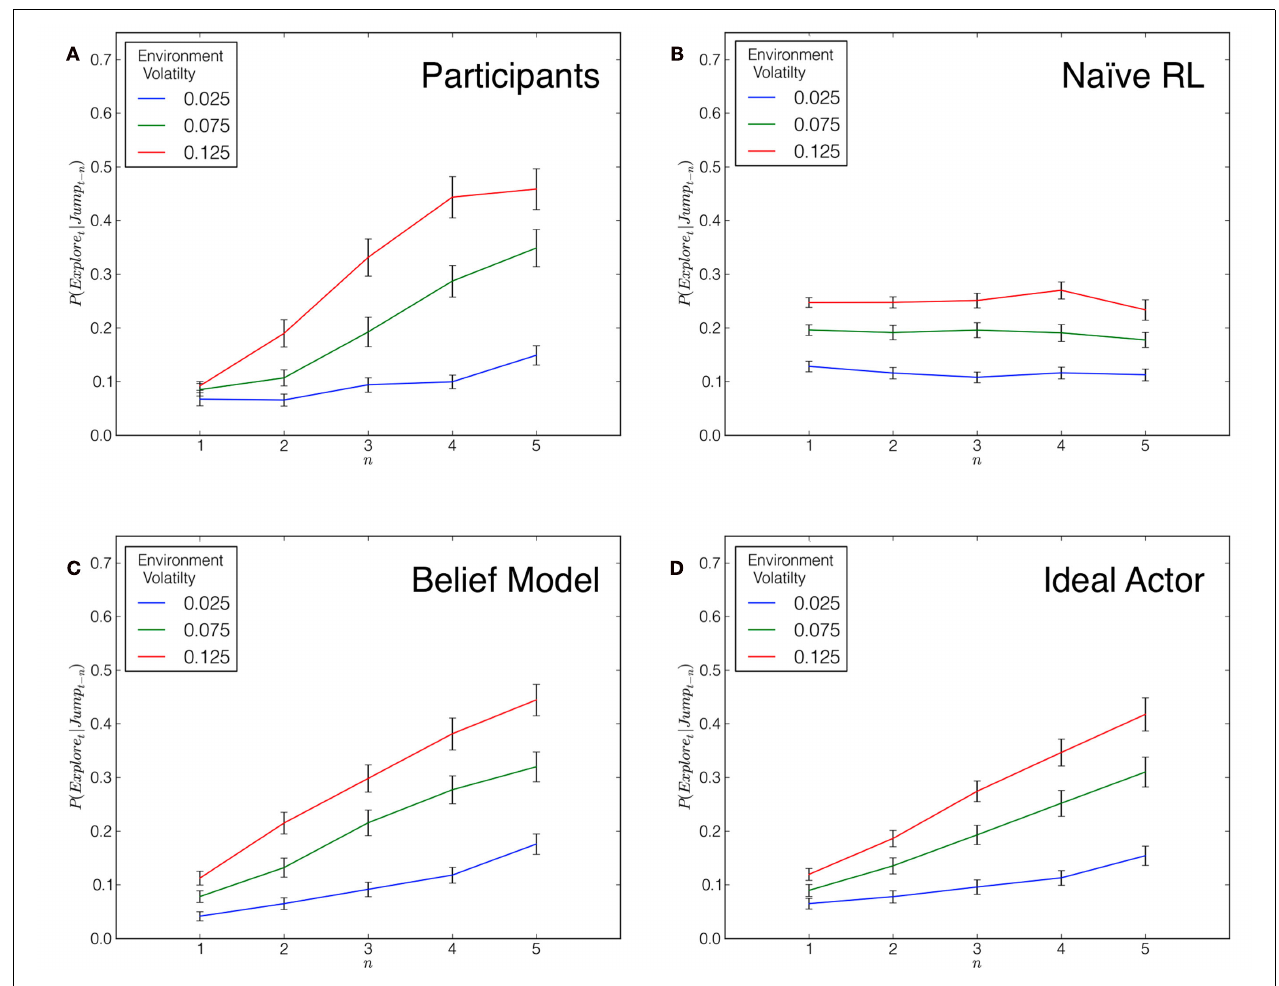
beginning with the observation of a jump, three exploitative choices are made before an exploratory choice. Critically, the reflective nature of the Belief model and the Ideal Actor results in a monotonically increasing hazard rate as the models’ certainty about the relative optimality of the options decays over